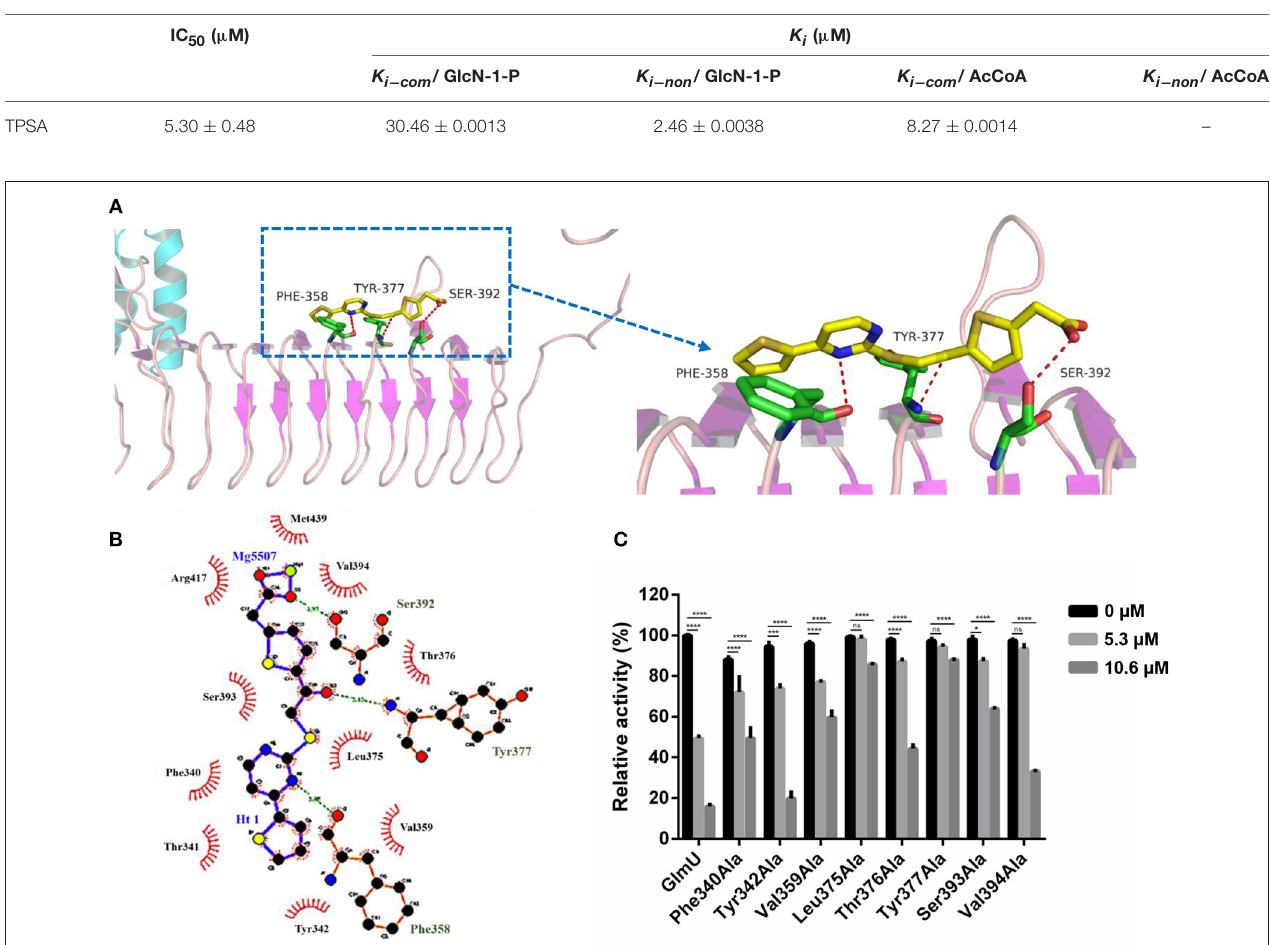
FIGURE 2 | Post-docking interactions between active site residues of GlmU acetyltransferase with TPSA (A,B) and the relative activity of different GlmU protein mutants (C) . In (C) , the experiment was carried out in triplicate and the graph indicates the mean value with standard deviation bars. Differences among groups were calculated by unpaired two-tailed t -test. The asterisks represent the statistical differences between the relative activity of GlmU and GlmU mutants in different concentrations of TPSA-treated group. ns, no significance; * P < 0.05; *** P < 0.001; **** P < 0.0001 (The P- values of untreated group to 5.3 µ M TPSA treated group for GlmU, P < 0.0001; Phe340Ala, P < 0.0001; Tyr342Ala, P < 0.0001; Val359Ala, P < 0.0001; Leu375Ala, P = 0.5572; Thr376Ala, P < 0.0001; Tyr377Ala, P = 0.0815; Ser393Ala, P = 0.0012 and Val394Ala, P = 0.3158. The P- values of untreated group to 10.6 µ M TPSA treated group for GlmU, P < 0.0001; Phe340Ala, P < 0.0001; Tyr342Ala, P < 0.0001; Val359Ala, P < 0.0001; Leu375Ala, P < 0.0001; Thr376Ala, P < 0.0001; Tyr377Ala, P < 0.0001; Ser393Ala, P < 0.0001 and Val394Ala, P < 0.0001).